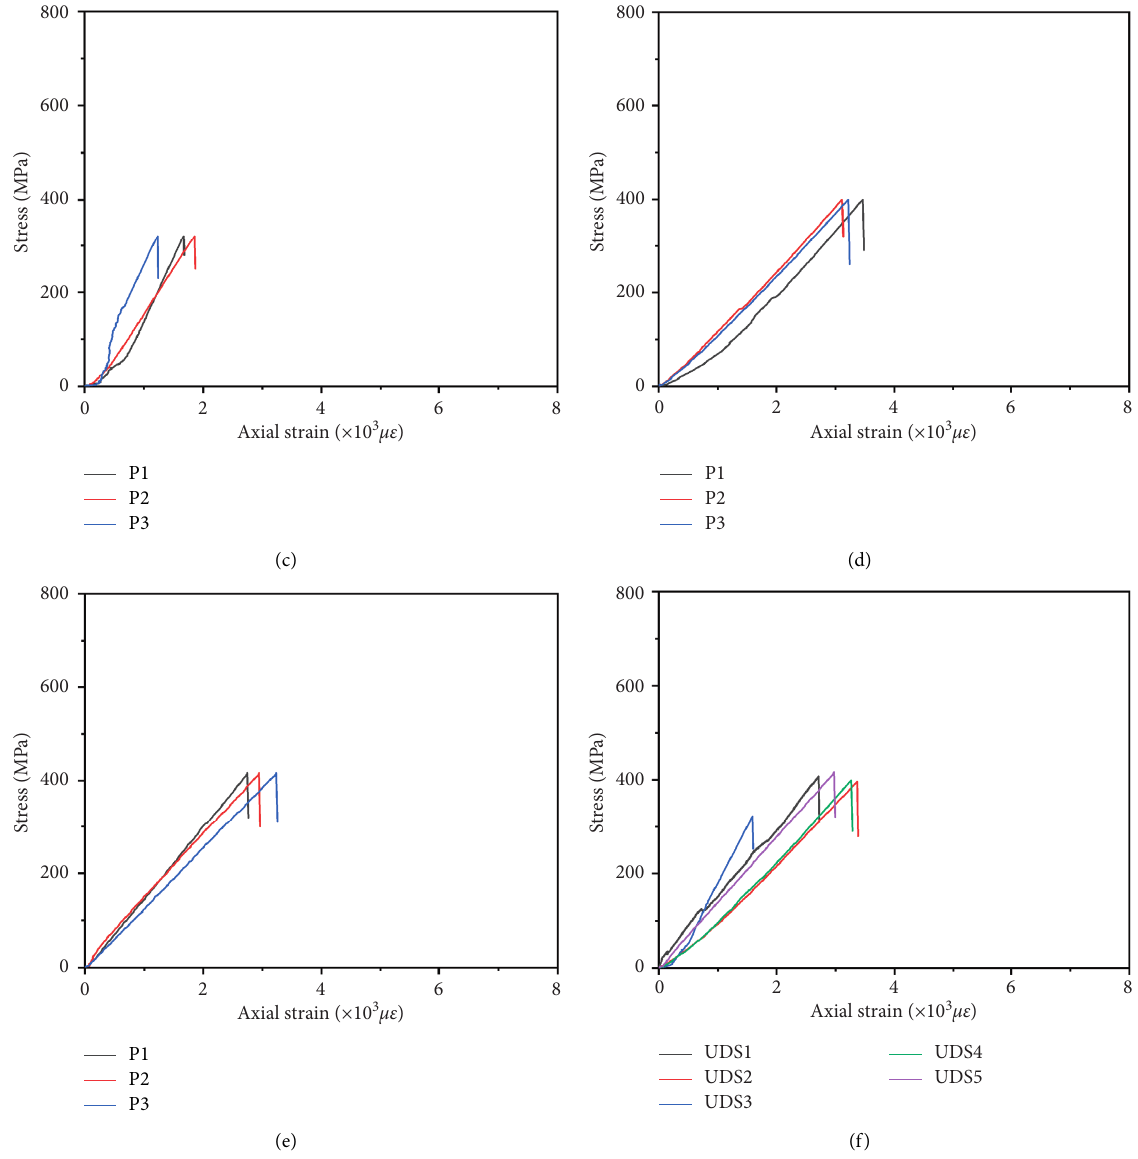
Figure 17: Stress-strain curves of CFRP rods anchored by traditional bond anchors. (a) UDS1. (b) UDS2. (c) UDS3. (d) UDS4. (e) UDS5. (f) Average.